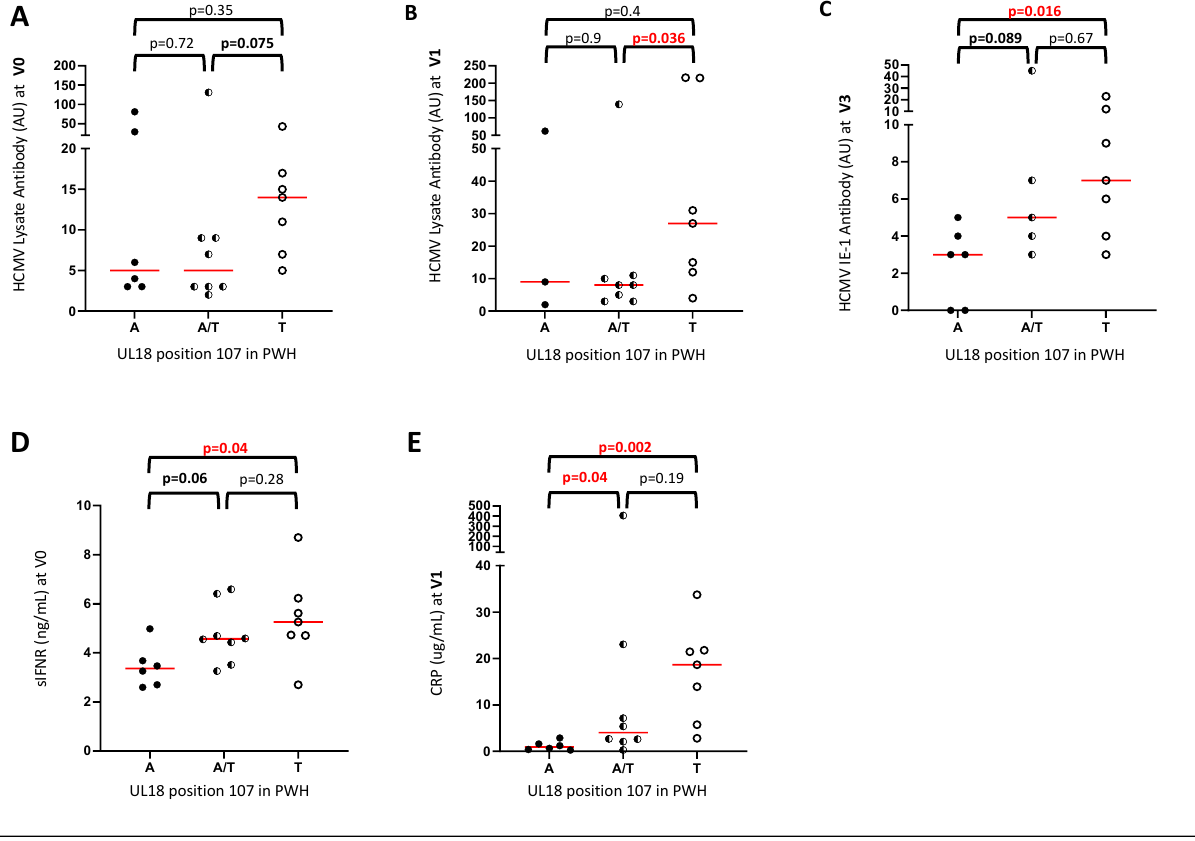
Figure 3. PWH carrying A107T had higher levels of HCMV reactive antibody levels and inflammatory biomarkers over time. ( A ) HCMV lysate-reactive antibodies at V0 (0 months on ART) with A, A/T or T at position 107; ( B ) HCMV lysate-reactive antibodies at V1 (1 month on ART) with A, A/T or T at position 107; ( C ) HCMV IE-1-reactive antibodies at V3 (3 months on ART) with A, A/T or T at position 107; ( D ) plasma soluble IFN α R levels at V0 with A, A/T or T at position 107; ( E ) plasma CRP levels at V1 with A, A/T or T at position 107. Red lines mark median values. HCMV encoding T at position 107 was present in Australian RTR. Eleven of 15 in-